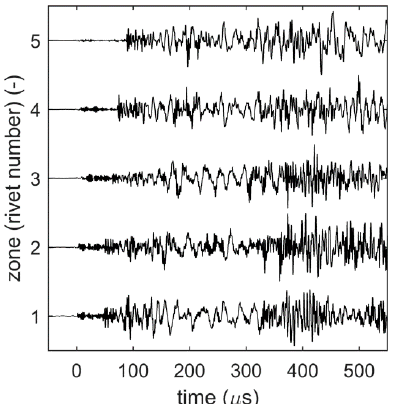
Figure 9. Samples of AE waveforms simulated at the rivets (the first five zones). To allow comparison, the waveforms were normalized.